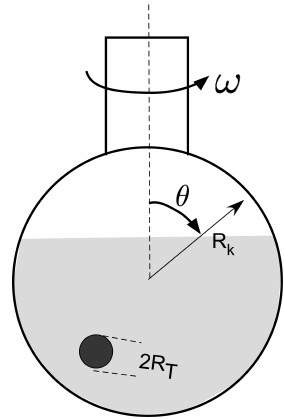
Figure 9. Drops of different volume (leading to different drop radii R rotating bulb of radius R which was inclined at an angle θ to the vertical and rotated with K different angular frequencies ω = 2 πf .